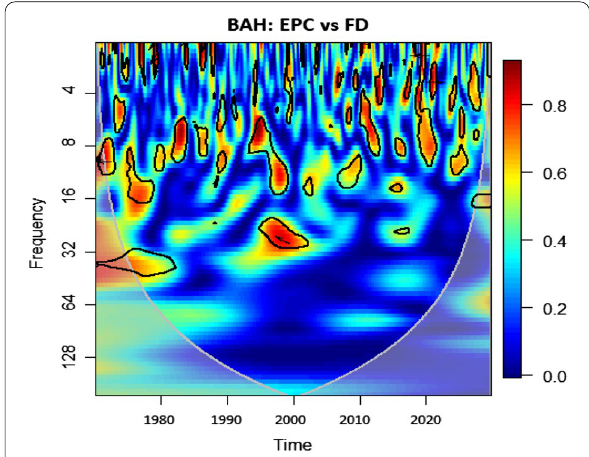
Fig. 7 Comovement between the electrical power consumption and financial development in